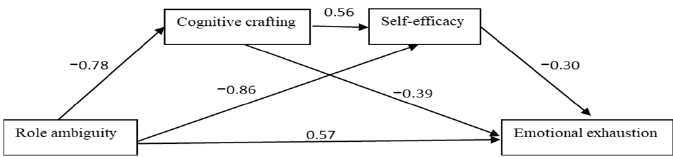
Figure 5. Paths values for the sequential mediation model 2.